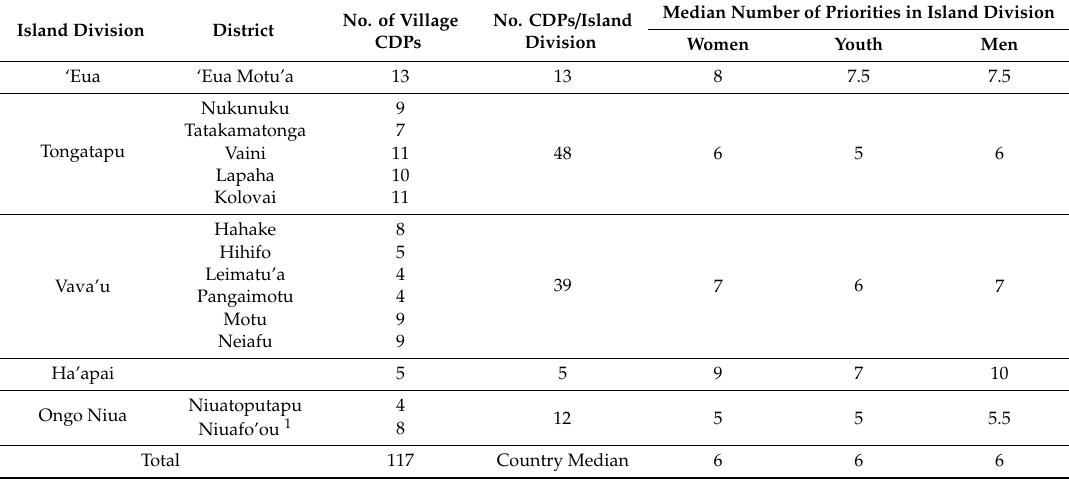
Table 9. The number of accessed village community development plans for Districts and Island Divisions in Tonga and the medium number of identified priorities identified by women, youths and men within each Island Division